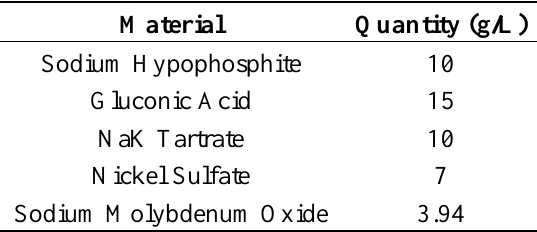
Table 2. Composition of electroless Ni-Mo-P